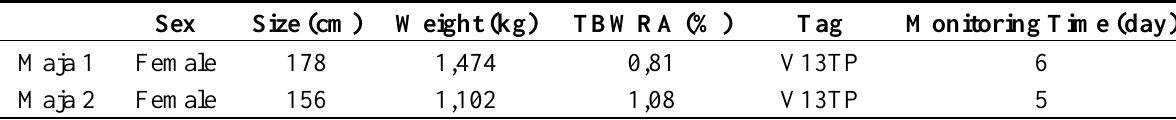
Table 1. Characteristics of the tagged spider